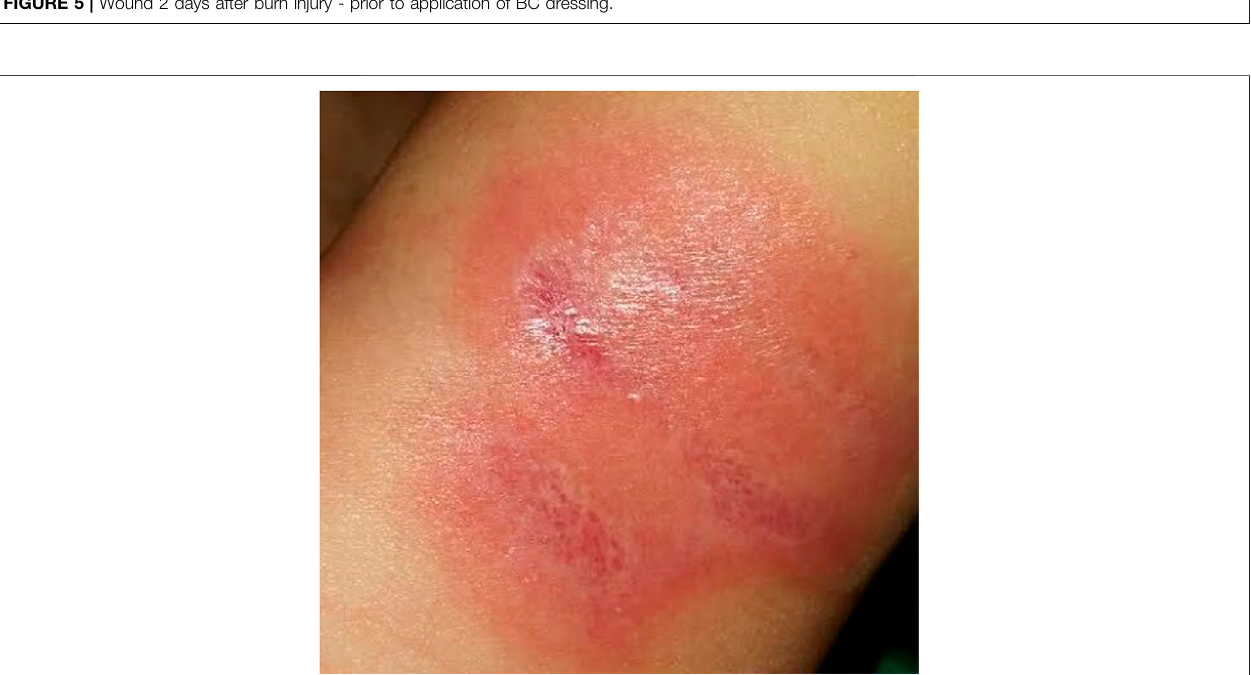
FIGURE 5 | Wound 2 days after burn injury - prior to application of BC dressing.